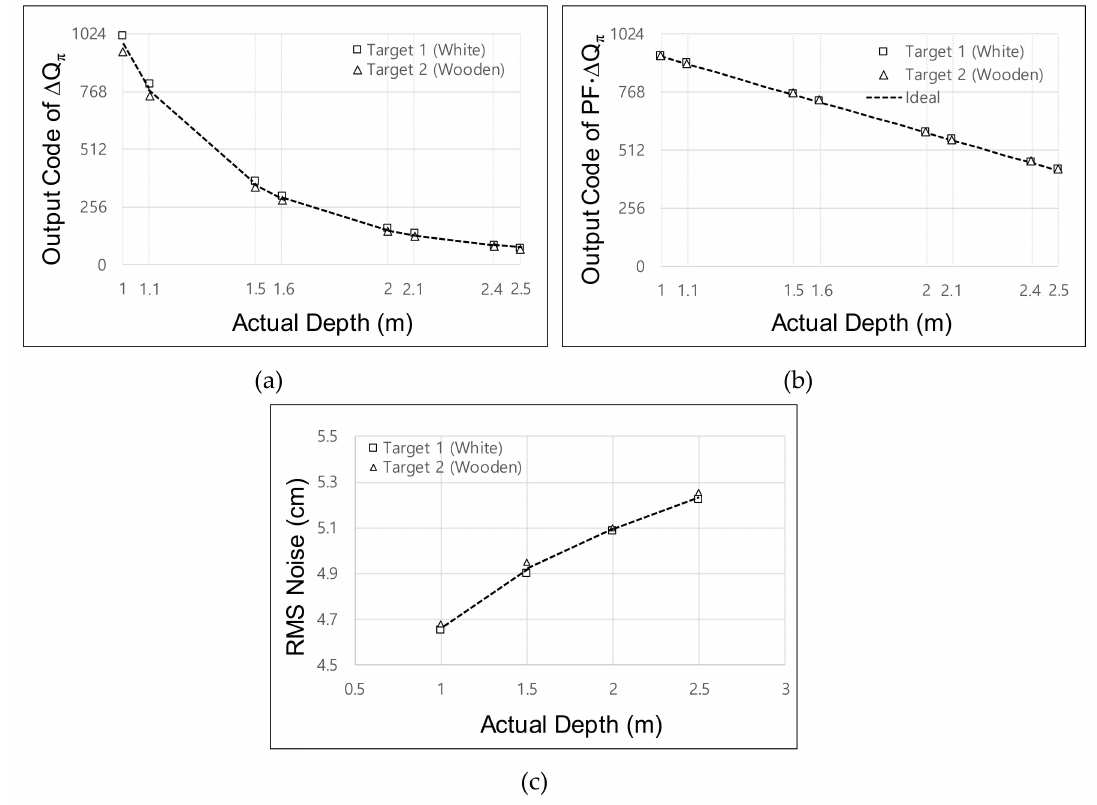
Figure 10. Measured ∆ Q π scaled by the maximum ∆ Q TOT and the results for the depth frame di ff erence: ( a ) ∆ Q π without application of a two-step comparison scheme; ( b ) ∆ Q π with application of a two-step comparison scheme; ( c ) RMS error of ∆ Q π